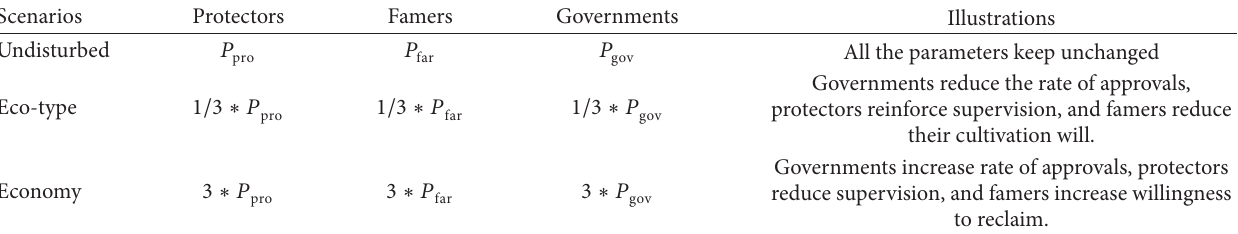
Table 2: Realization of scenarios through agent parameter